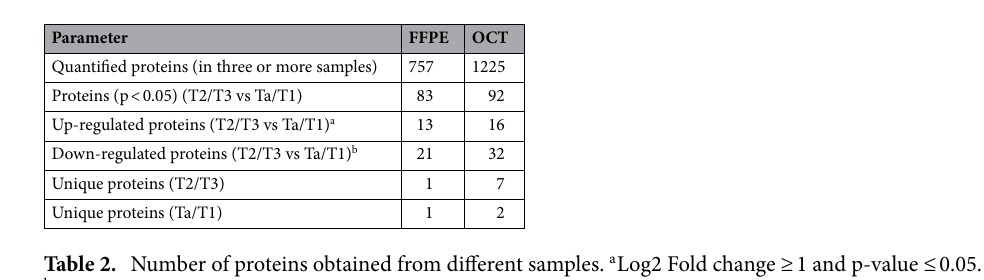
Table 2. Number of proteins obtained from different samples. a Log2 Fold change ≥ 1 and p-value ≤ 0.05. b Log2 Fold change ≤ − 1 and p-value ≤ 0.05.